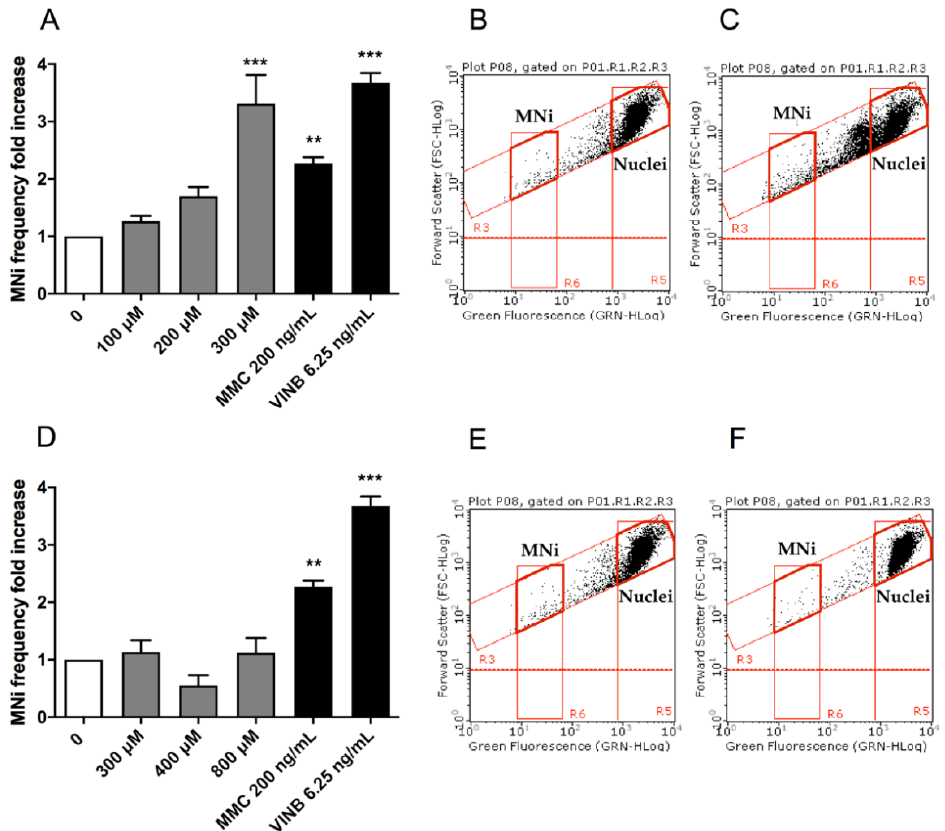
Figure 3. MNi fold increase in TK6 cells after 26 h treatment with ( ± )cis-4,4 (cid:48) -DMAR ( A ) and ( ± )trans- 4,4 (cid:48) -DMAR ( D ) or positive controls (MMC, VINB) at the indicated concentrations compared to the concurrent negative control [0 µ M]. Each bar represents the mean ± SEM of three independent experiments. Data were analysed using one-way repeated measures ANOVA followed by Dunnet as post-test. ** p < 0.01 vs. [0 µ M]; *** p < 0.001 vs. [0 µ M]. Dot plots obtained by FCM in the concurrent negative controls ( B , E ), ( ± )cis-4,4 (cid:48) -DMAR 300 µ M ( C ) and ( ± )trans-4,4 (cid:48) -DMAR 800 µ M ( F ). “MNi” and “Nuclei” indicate the regions of the dot plot where MNi and nuclei can be found.